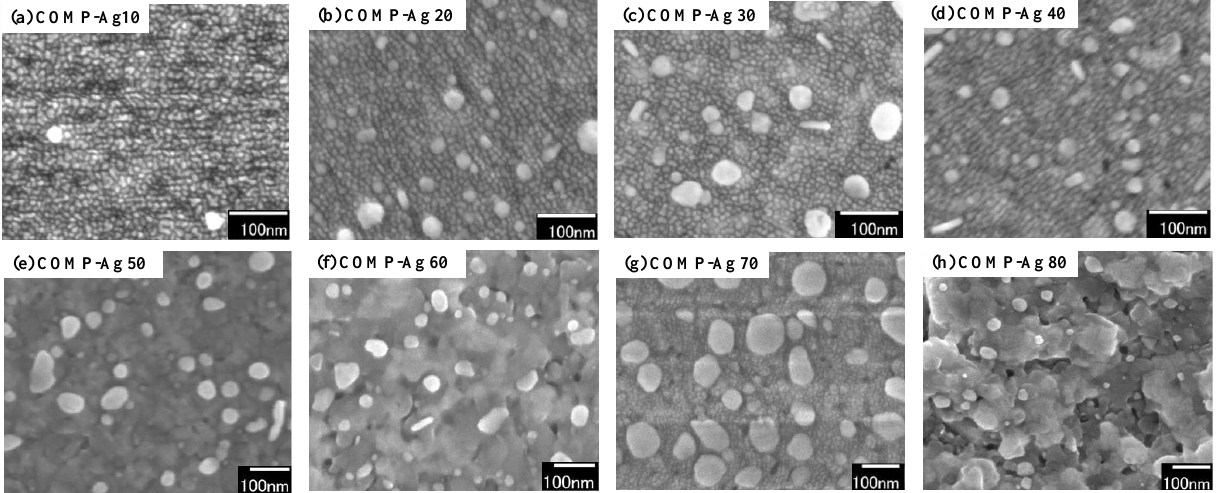
Figure 5. UV-vis absorption spectra for TiO